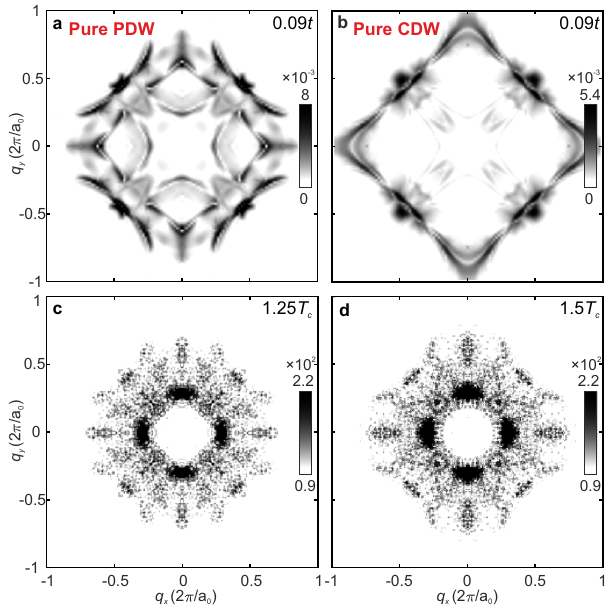
Fig. 5 Discrimination of CDW from PDW QPI Signature in the Pseudogap State. a Predicted QPI signature Λ P ð q ; 20meV Þ of pure 8 a 0 PDW state at T = 0.09 t . b Predicted Λ C ð q ; 20meV Þ of pure 4 a 0 CDW state at T = 0.09 t . The CDW states show very different features compared to the PDW state. c Measured Λ ð q ; 20meV Þ of Bi 2 Sr 2 CaDyCu 2 O 8 ( p ≈ 0.08) for the pseudogap phase at T = 1.25 T c . d Measured Λ ð q ; 20meV Þ of Bi 2 Sr 2 CaDyCu 2 O 8 ( p ≈ 0.08) for the pseudogap phase at T = 1.5 T c . e The measurements of the pseudogap phase agree much better with the pure PDW scenario ( a ) than with the pure CDW ( b